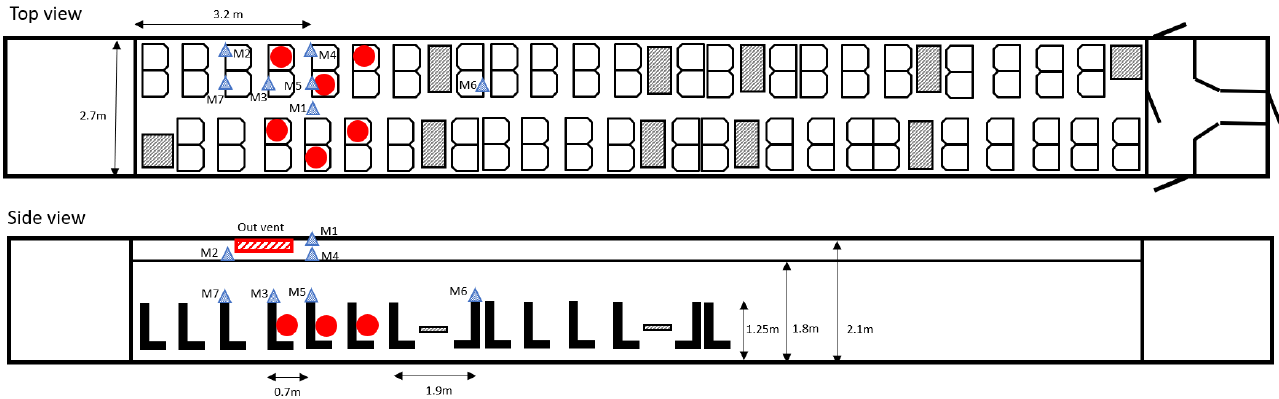
Figure 4. CO 2 experiment set up for end of carriage. Red circles indicate position of passengers, and blue triangles indicate position of CO 2